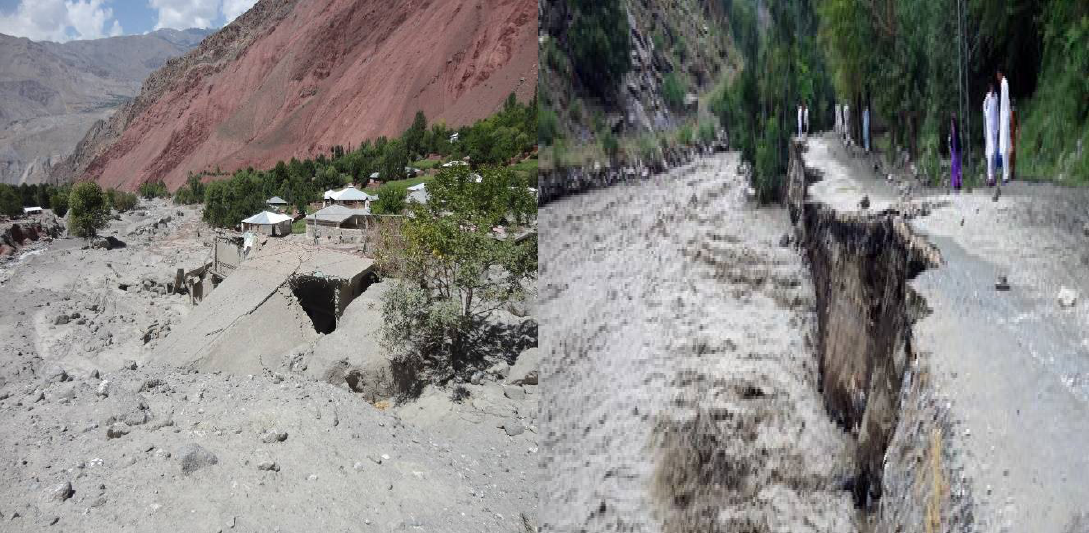
Figure 2. Flash flooding with damage caused in the study area.